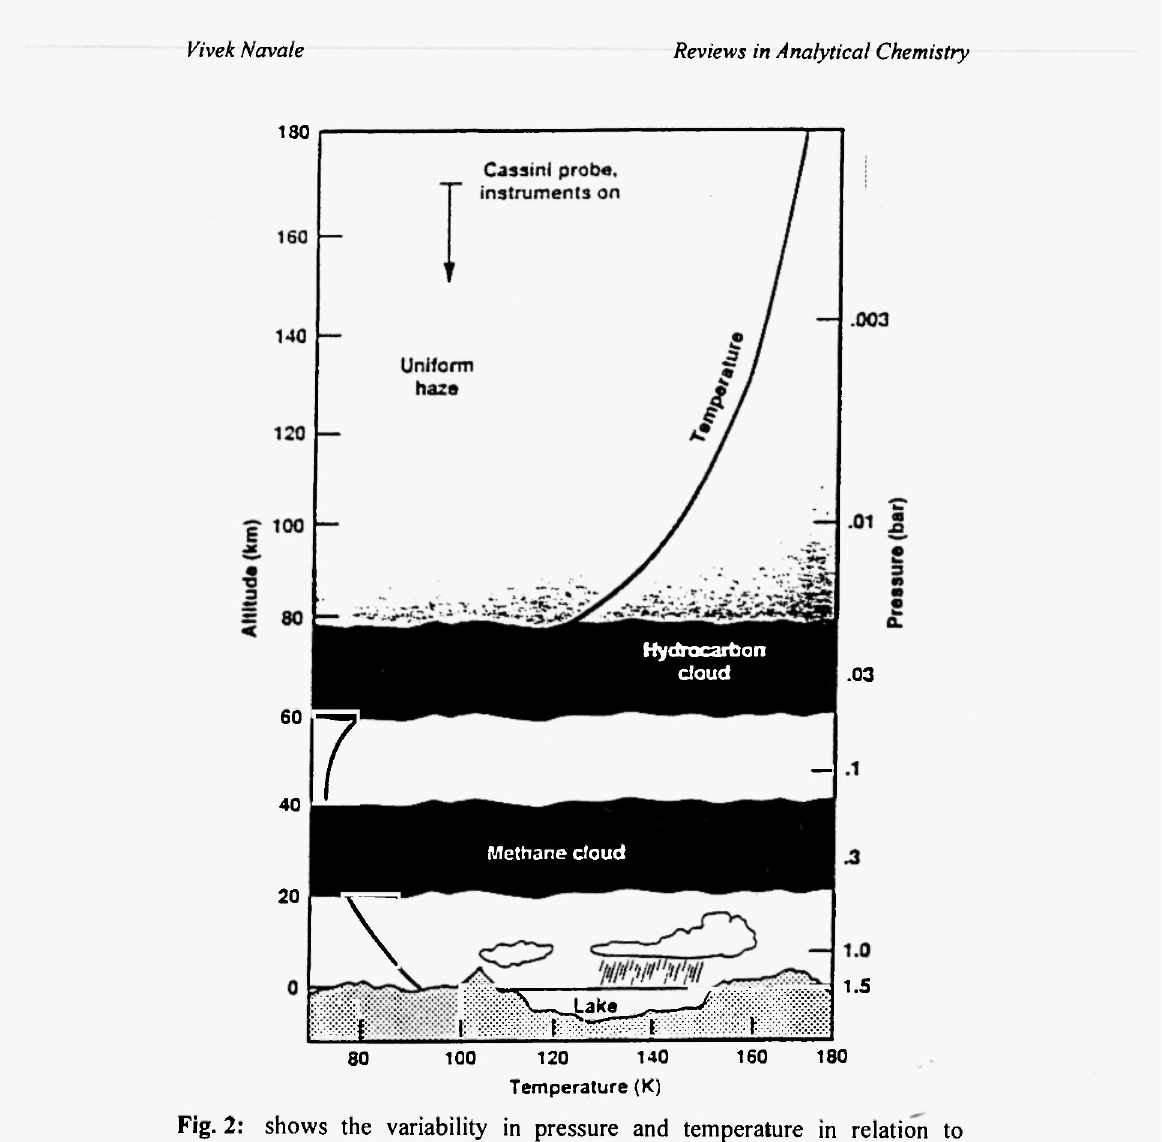
Fig. 2: shows the variability in pressure and temperature in relation to changes with altitude of Titan's atmosphere. Also, indicated in the figure is the altitude where the Cassini-Huygens probe instruments will become operational (courtesy of T. Scattergood, 1992, ref. /56/, reprinted with permission from NASA-Ames Research